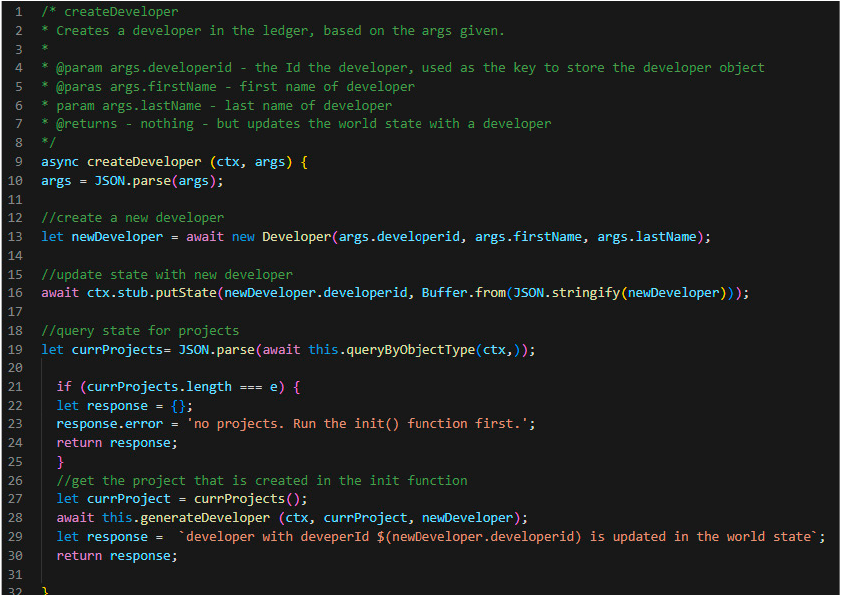
Figure 11. Smart contract for creating a developer.